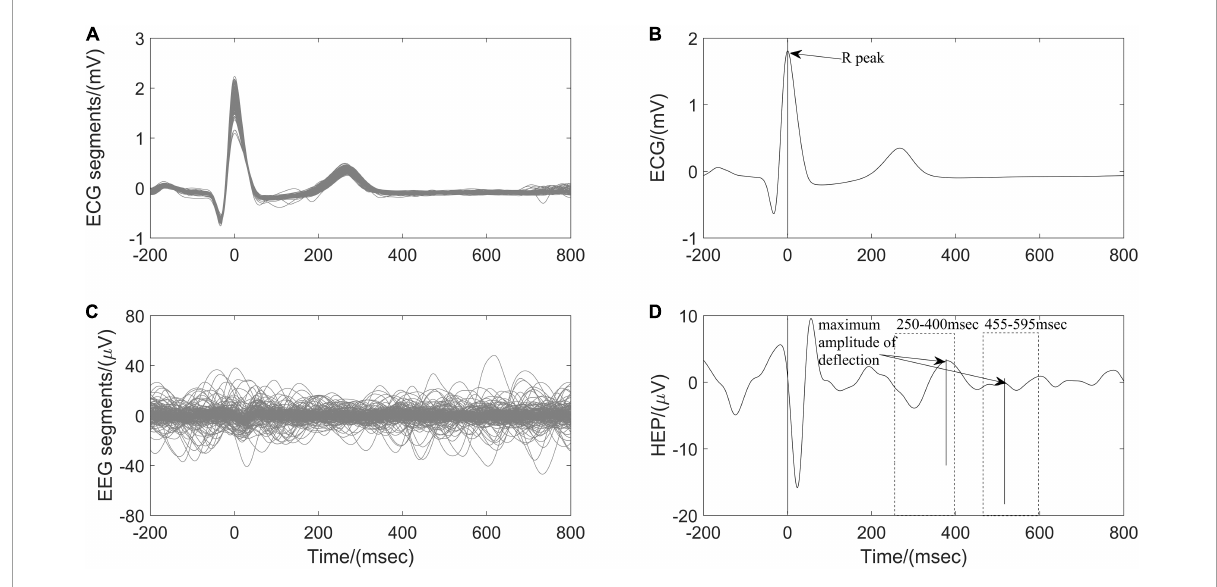
FIGURE4 Computation of heartbeat evoked potential (HEP) for one participant According to (A) the detected R peaks of electrocardiography (ECG) signals, (B) corresponding electroencephalography (EEG) brain activity is aligned. (C) The HEP is obtained by averaging over all clean EEG signals time-locked to (D) ECG R